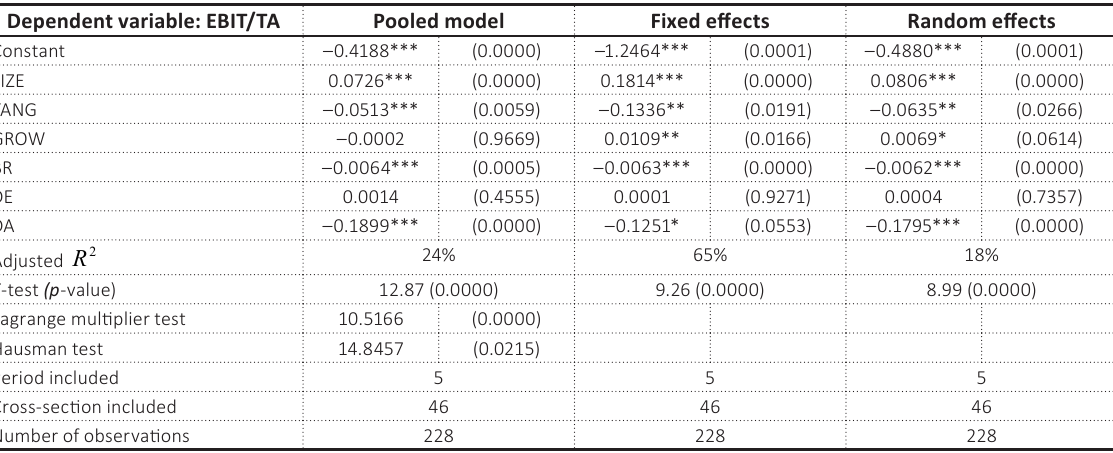
Table 5. Ordinary least squares regression